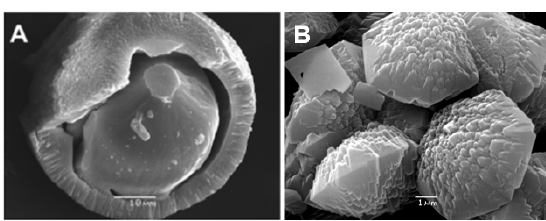
Figure 6. A - amorphous core and crystalline shell of a particle (2 000 × ), B - well developed polycrystalline particles (10 000 × ).